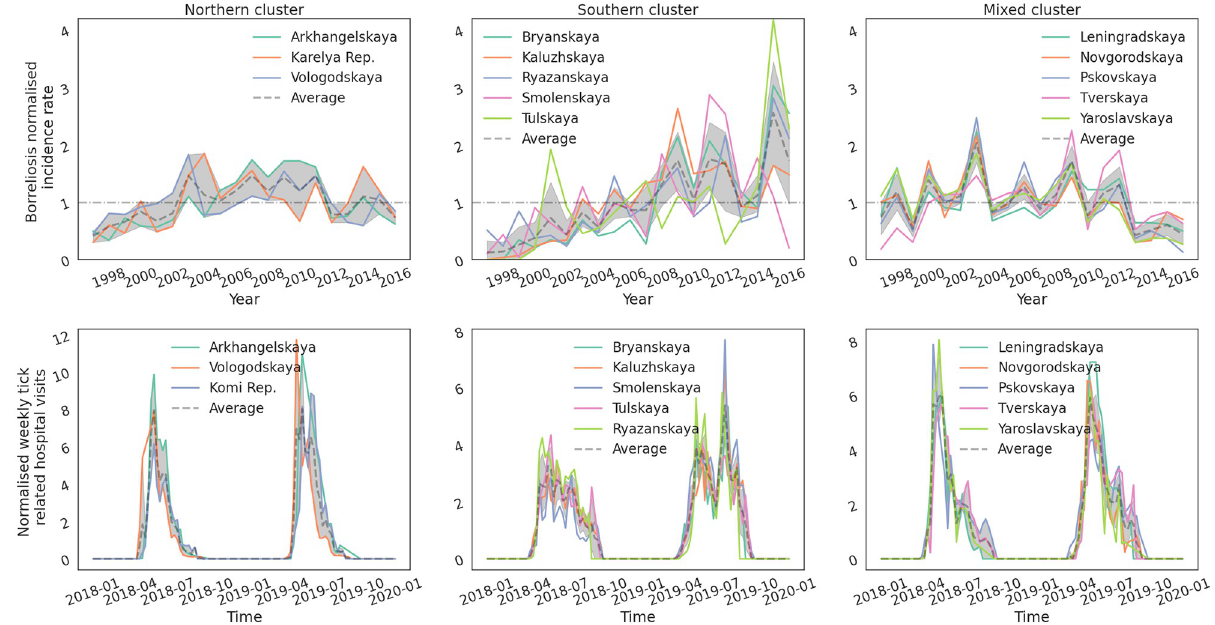
Fig 2. The yearly normalised (with respect to the mean) borreliosis incidence rates for the federal regions investigated (top panels) and normalised (with respect to the mean) weekly tick related hospital visits (bottom row of panels). The Northern cluster of federal regions is shown on the left column of panels, the Southern cluster in the middle column and the mixed cluster on the right column. The dashed line shows the average incidence rate for the federal regions in each region, whereas the dash-dot line indicates the mean for each cluster.